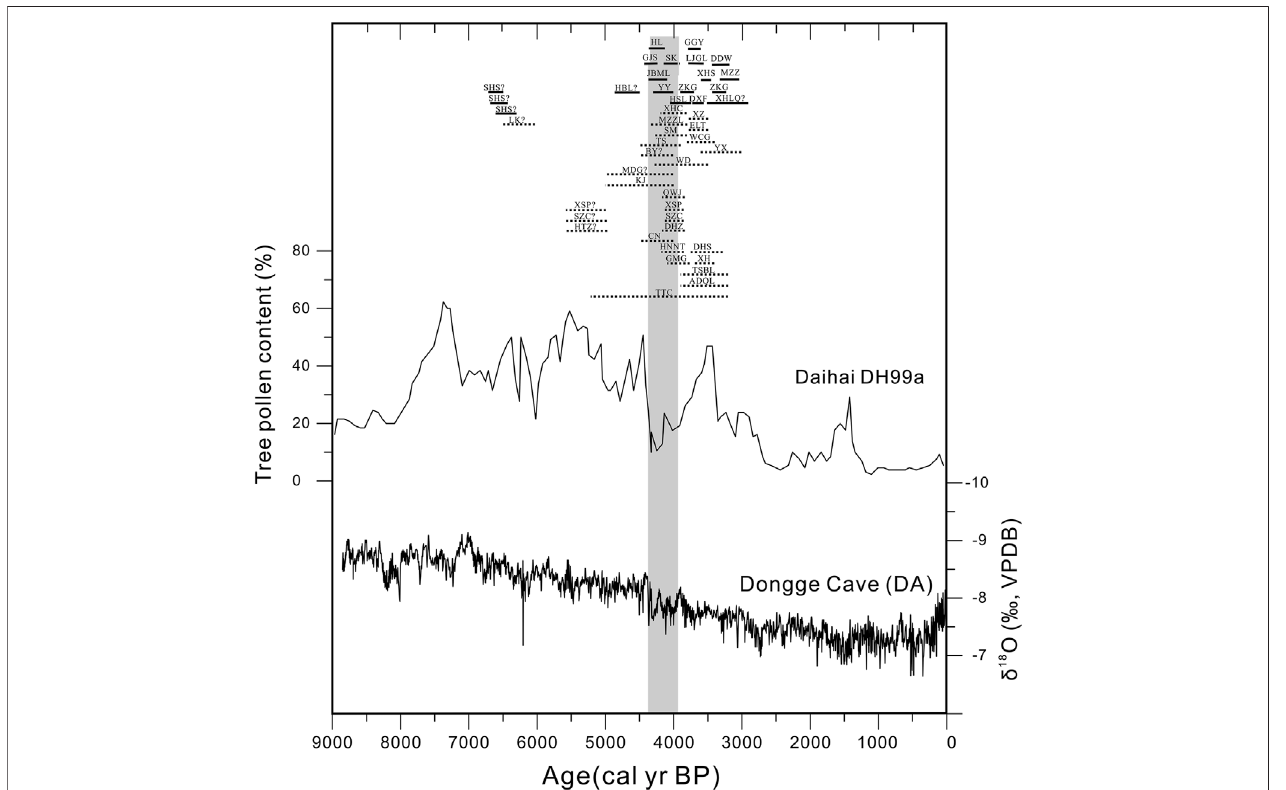
FIGURE 7 | Ages of the remains of domestic sheep at sites in North China (solid line indicates AMS 14C ages, dashed line indicates age inferred from the cultural context, and “ ? ” indicates that it is uncertain whether the sheep were domesticated). Also shown are tree pollen percentages from Daihai (Xiao et al., 2004) and the oxygen isotope record from Dongge cave (Wang et al., 2017). The grey shading represents drought events at ∼ 4,200 cal yr BP. The full names of the sites are shown in Table 1 .